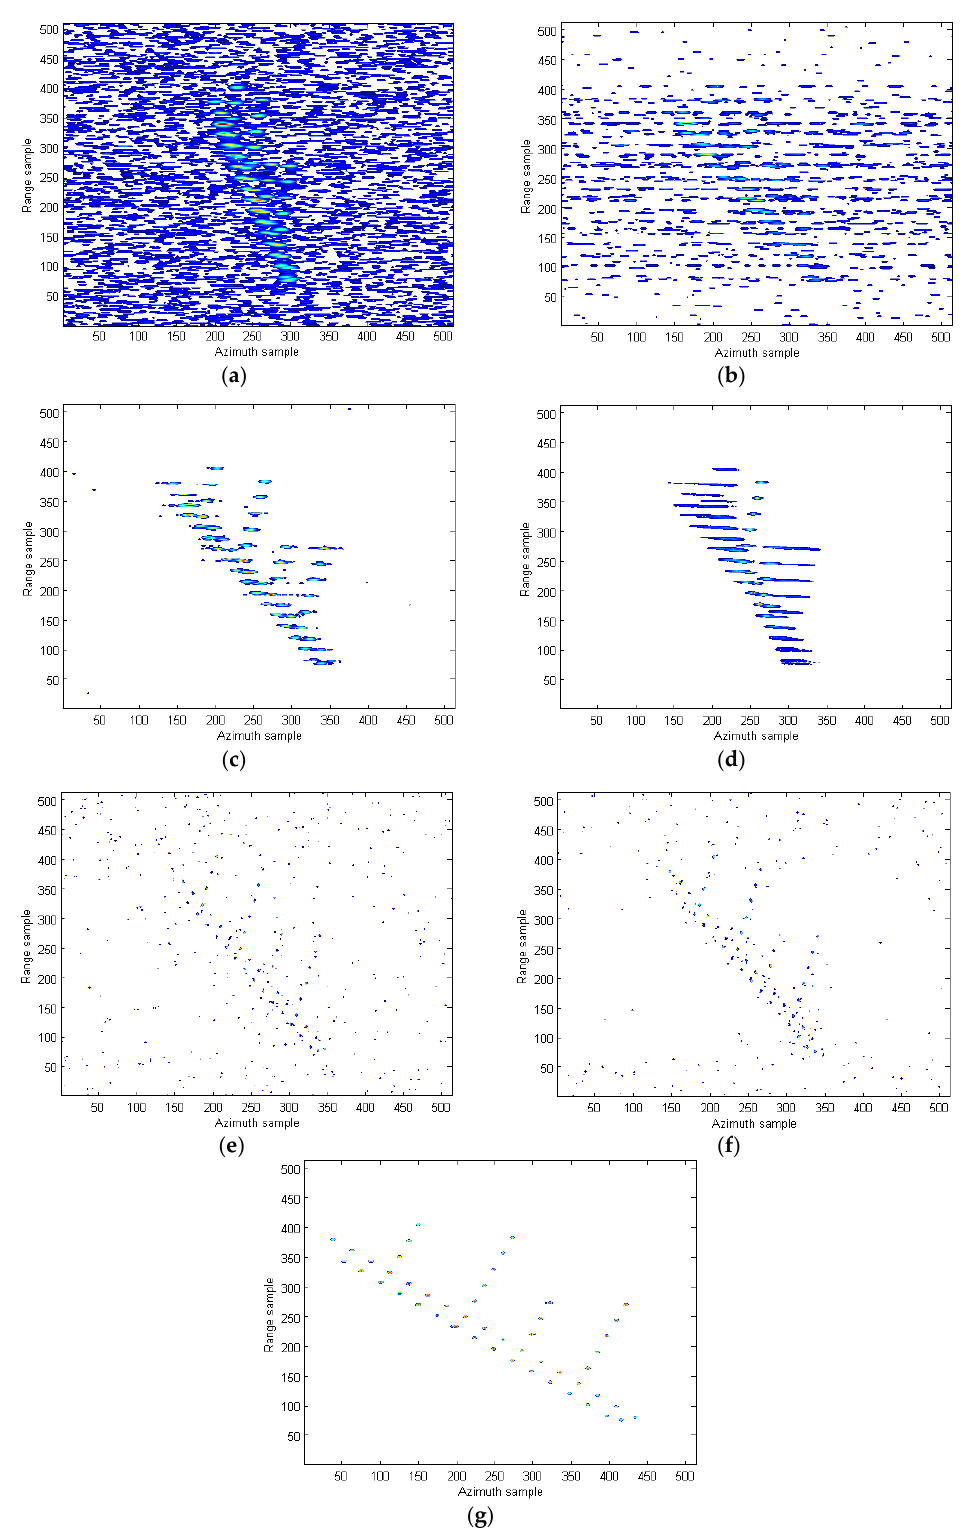
Figure 10. ISAR images of the simulated data under SNR = 5 dB. ( a ) STFT algorithm in [10]; ( b ) WVD algorithm in [12]; ( c ) SPWVD method in [13]; ( d ) RCD method in [15]; ( e ) IHAF-ICPF method in [7]; ( f ) CIGCPF-CICPF method in [9]; ( g ) our proposed method.